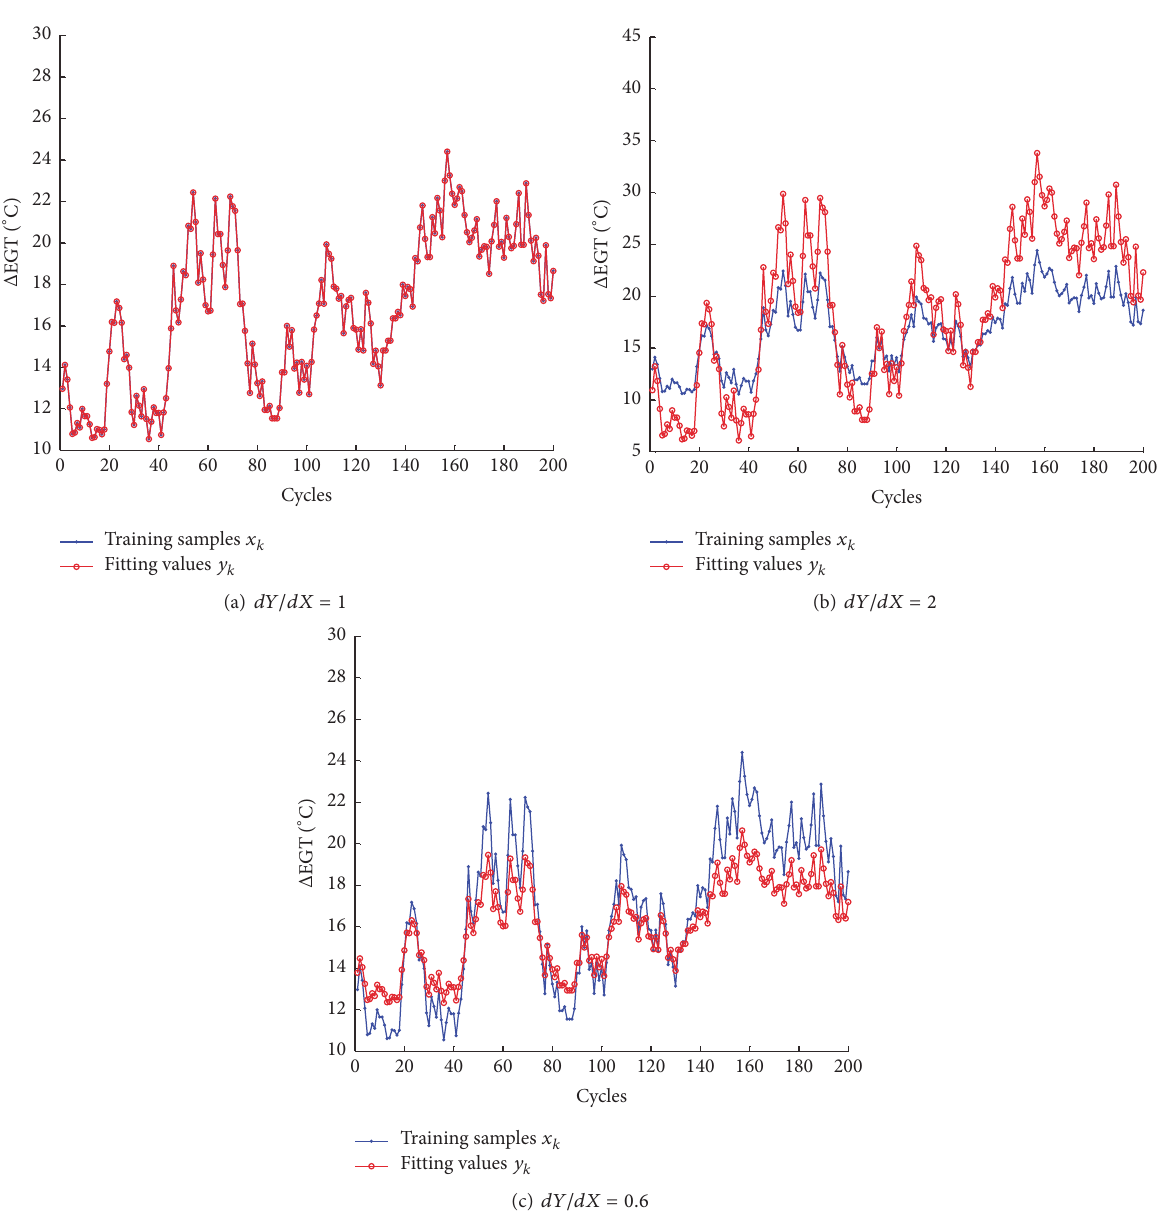
Figure 4: Position relations between fitting value 𝑦 𝑘 and training sample 𝑥 𝑘 under different fitting